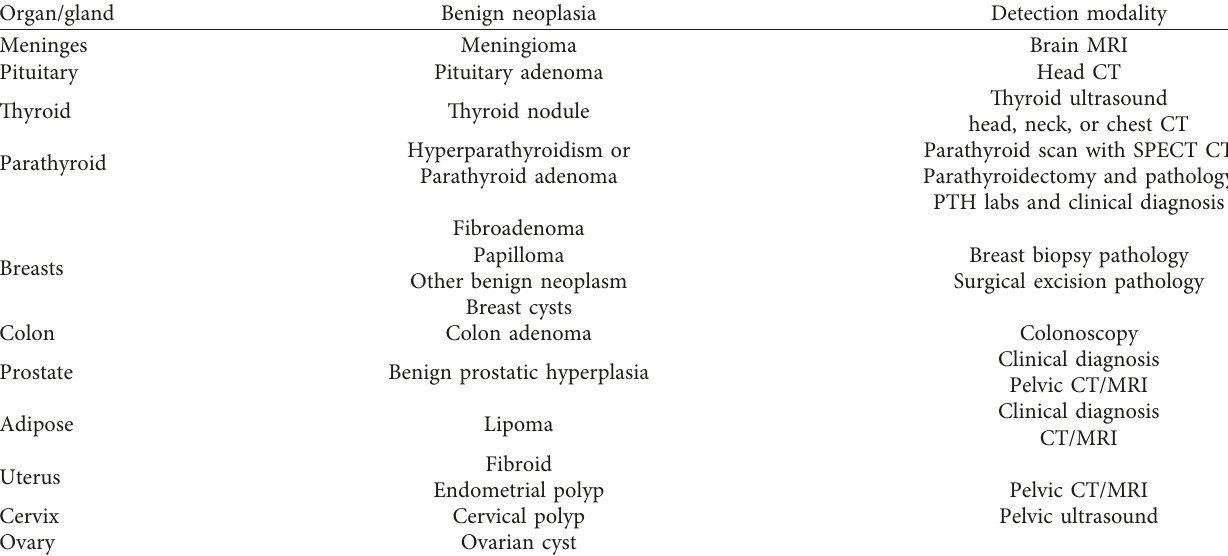
Table 2: Outcome assessments on other imaging modalities.